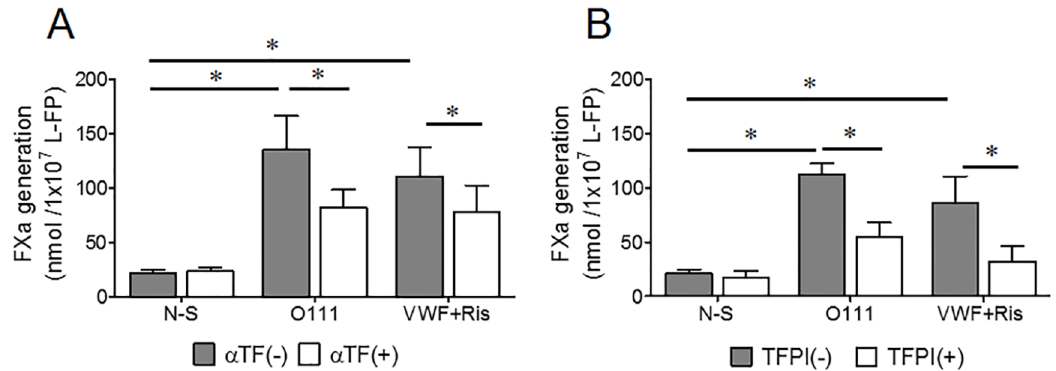
Fig 4. Inhibition of platelet procoagulant activity induced by E . coli O111 by α TF MoAb and TFPI. Leukocyte-free platelets (L-FP) were pre-incubated with either α TF MoAb or TFPI, before stimulationwith E . coli O111 or VWF+Ris (positivecontrol). Inhibition of TF reducethe generationof FXa by the strain O111 around40% ( * p = 0.031, n = 6) and, when plateletswere activated with VWF+Ris, the inhibitionwas about 30% ( * p = 0.031, n = 5) (A). Data analyzedwith Wilcoxon signedrank test, two tails. Similar results were observedin L-FPs incubatedwith TFPI before the stimulationwith E . coli or VWF+Ris, reachinglevels of inhibitionof 50% ( * p 0.03, n = 4) and 60% ( * p 0.04, n = 5), respectively(B). The data were analyzedby Mann-Whitney